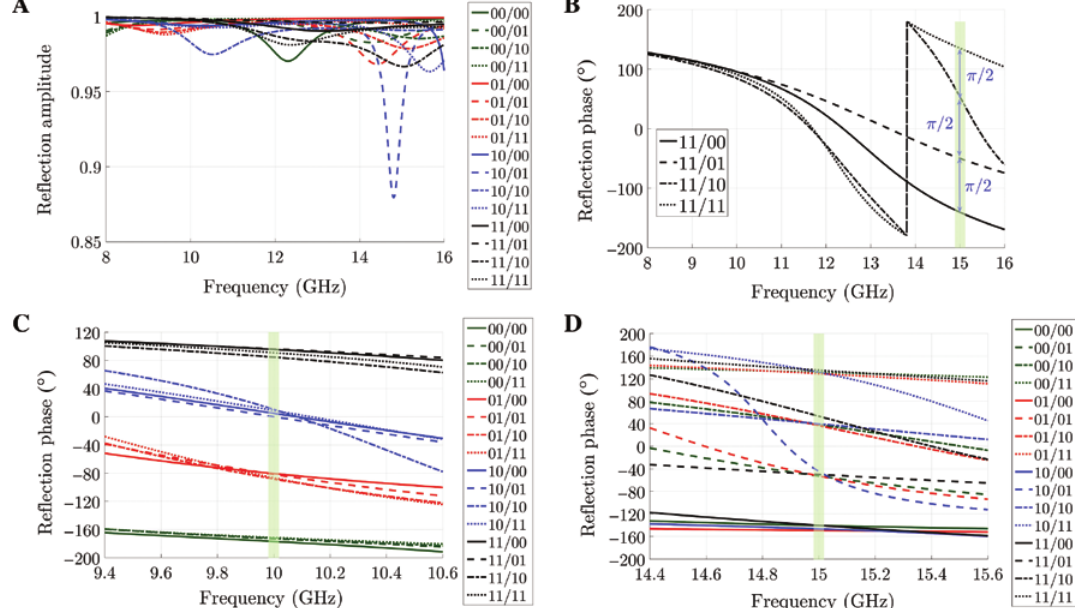
Figure 3: The reflection phase and reflection amplitude spectra of the designed coding elements plotted for different frequency ranges. (A) The amplitude spectra of all 16 coding meta-atoms in the lower and higher frequency bands. (B) The reflection phase spectra of the last four meta-atoms where the shaded regions refer to the operating bands. The reflection phase spectra of all 16 coding particles in the (C) lower and (D) higher working bands. In the proposed coding metasurface (MS), there are 16 meta-atoms, each of which represents a specific digital phase state at the lower and upper frequency bands. Indeed, at the lower or upper frequency band, there are a total of 16 digital states in four groups of four phase curves in which each group has almost the same values (and so the same digital